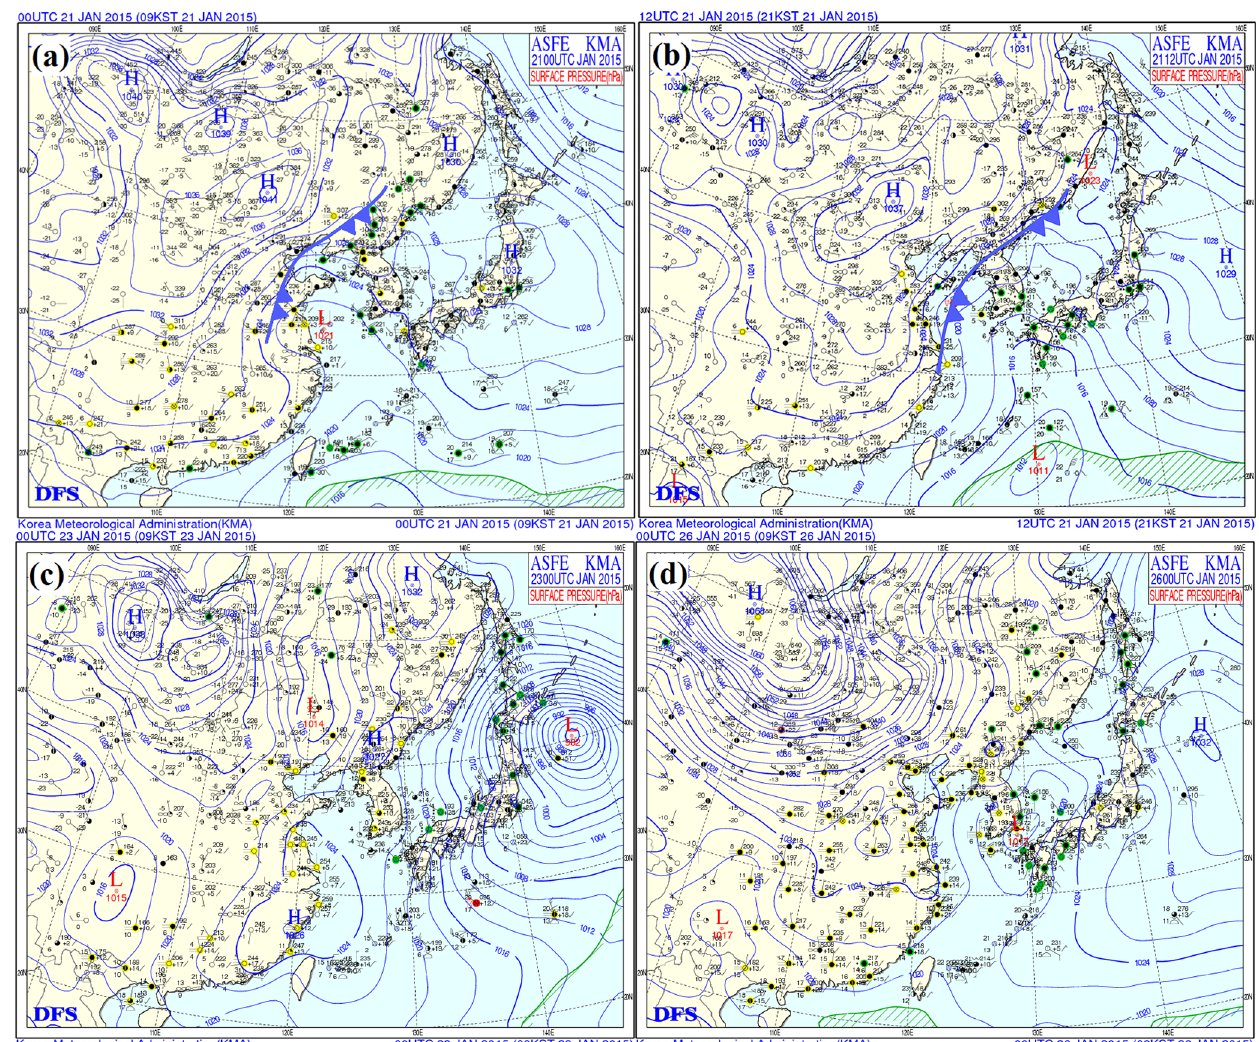
Figure 4. Surface weather patterns over eastern Asia at (a) 08:00LT 21 January, (b) 20:00LT 21 January, (c) 08:00LT 23 January, and (d) 08:00LT 26